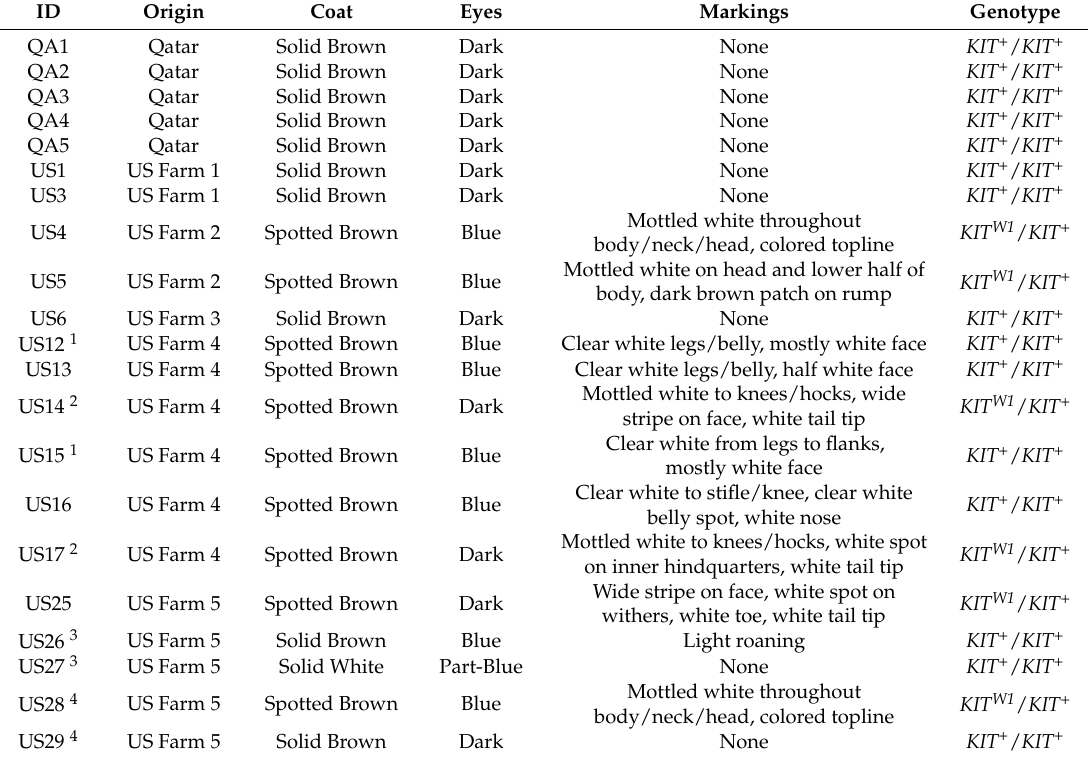
Table 1. Origin and coat color information for the camels in this